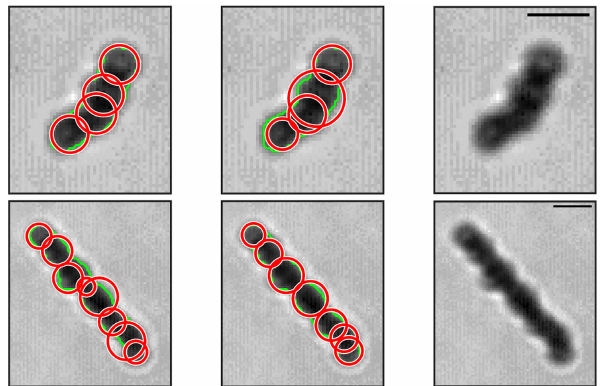
Figure 5. Element frozen droplets (red circles) determined using the phase-coding (left column) and two-stage CHT (middle column) techniques. Examples of two different FDAs are shown in the top and bottom rows, respectively. Original CPI images of FDAs are shown in the right column along with the 46µm scale bar. The de- tected boundary (green lines) of the FDAs are shown on panels in the left and middle